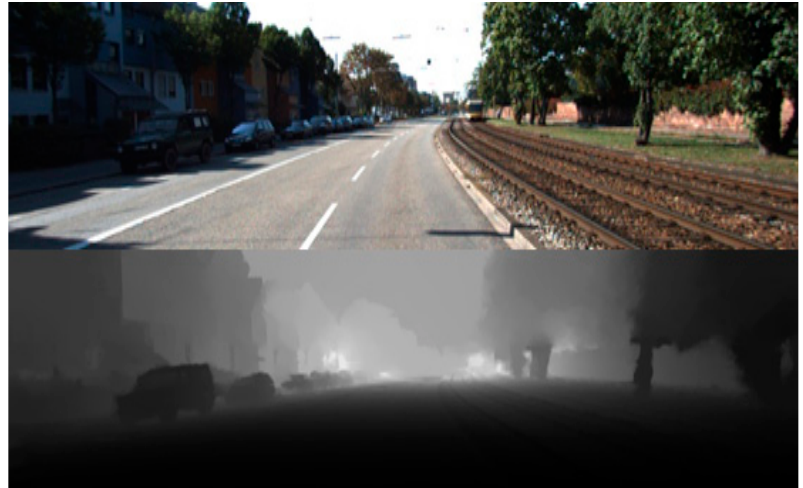
Figure 3. KITTI road-driving learning image.